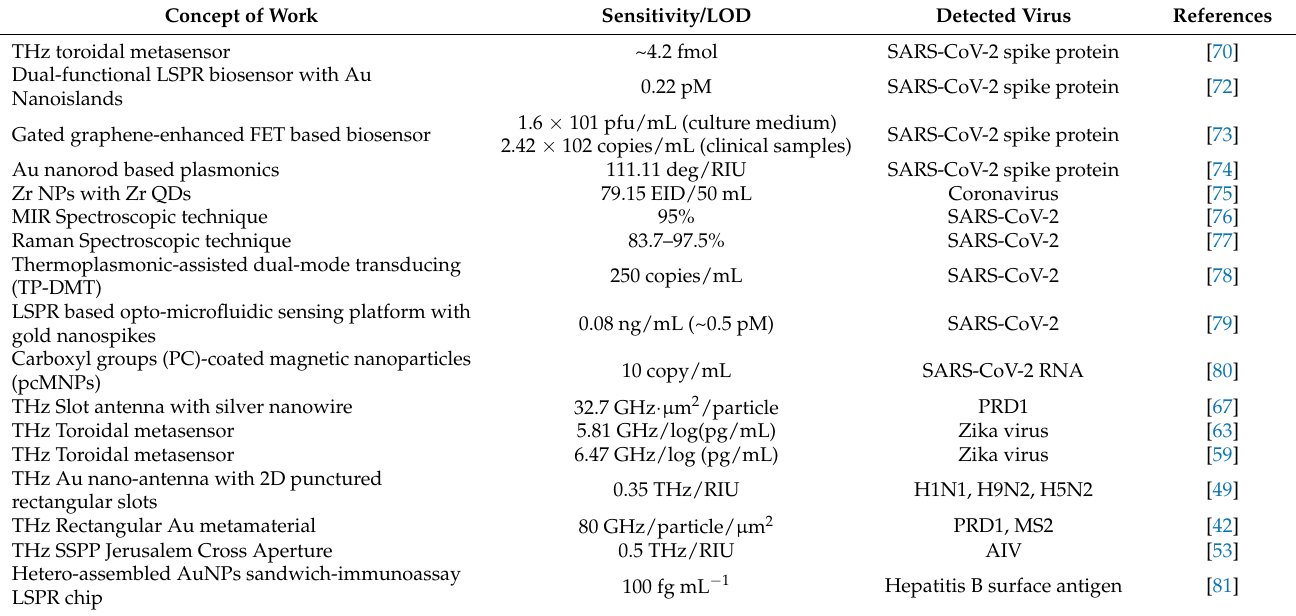
Figure 14. ( a ) Schematic workflow of the developed functionalized gold NPs conjugated with the respective SARS-CoV-2 antibody and spike proteins. ( b ) Measured transmission spectra of the THz metasensor device for different concentrations (4 fmol to 12 fmol) of SARS-CoV-2 spike protein. ( c , d ) Measured transmission spectra of the THz metasensor device for different concentrations (from 4 fmol to 30 fmol) of BSA and SARS-CoV-2 spike protein + BSA, respectively. Reprinted with permission from [70]. Copyright 2021 Elsevier. Table 1. Performance comparison of recent biosensors for virus detection including